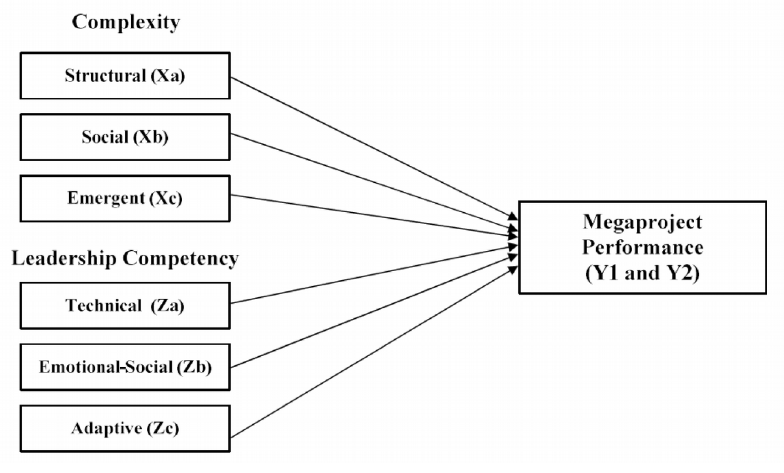
Figure 2. Theoretical